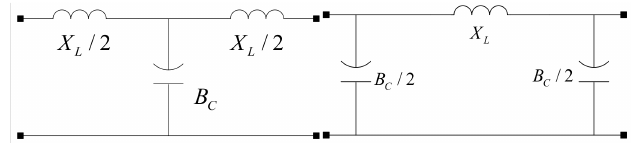
Figure 10. T-type and π -type